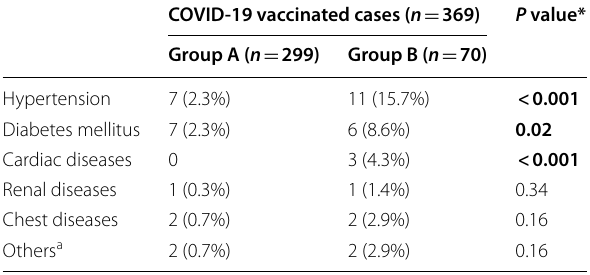
Table 2 Comorbidities among group A patients who did not developed post-vaccine COVID-19 infection ( n 299) versus = group B vaccinated participants who developed post-vaccine COVID-19 infection ( n 70) =